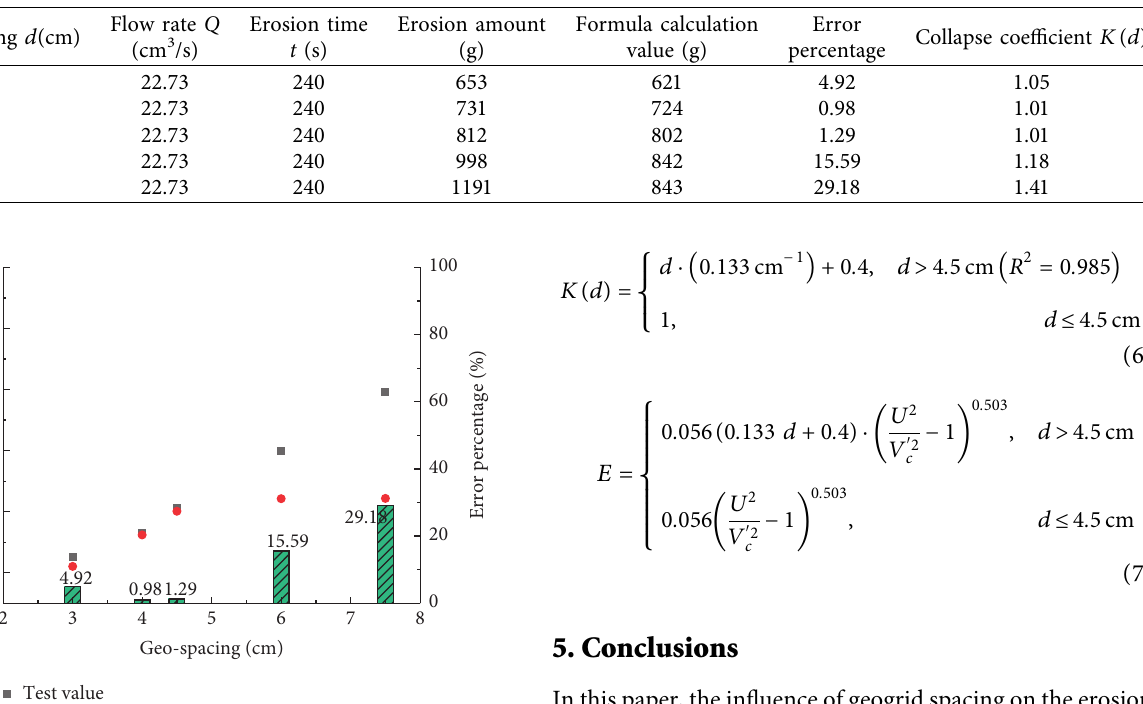
Table 7: Erosion amount of the overtopping test of the reinforced tailings